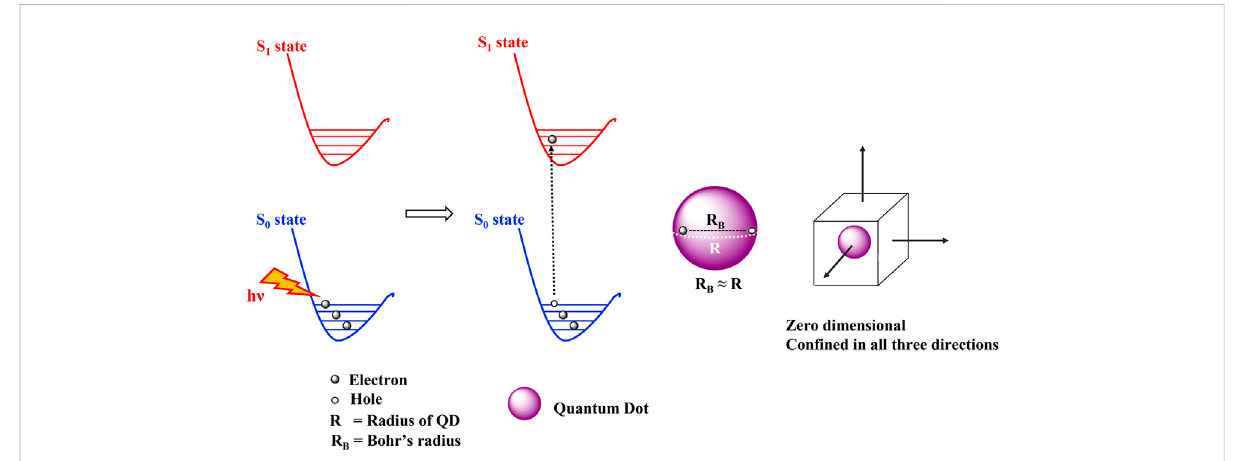
FIGURE 5 Quantum con fi nement effects seen in quantum dots. The Bohr ’ s radius of the exciton is similar to the radius of the QD leading to the spatial con fi nement of electrons in all the three